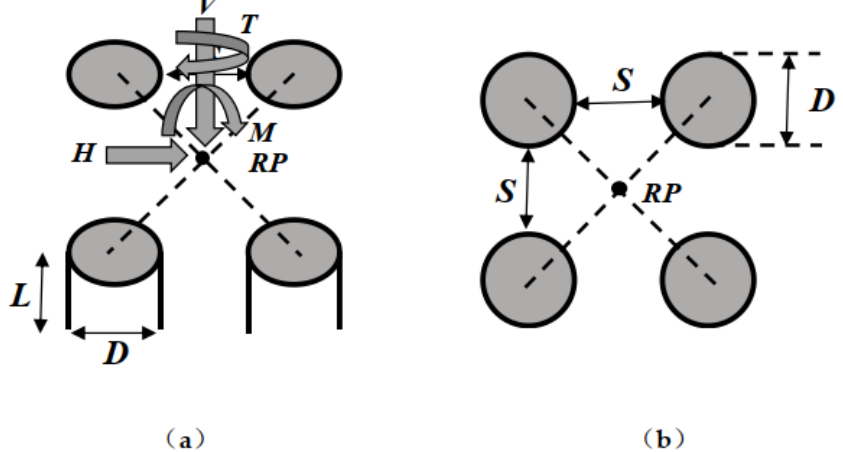
Figure 1. Geometry of four-barreled suction pile foundation and definition of loads: ( a ) oblique upper view; ( b ) top view.